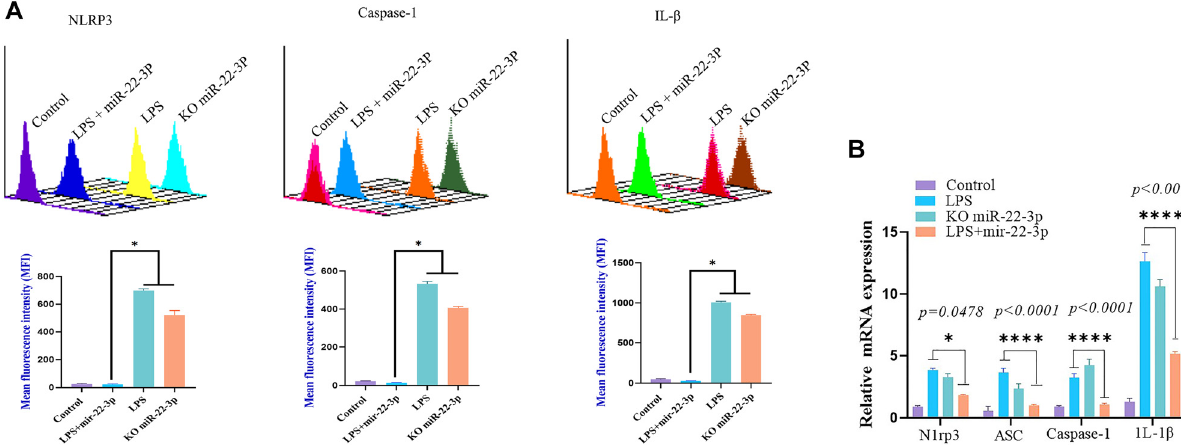
Figure 3: (A) The effect of up-regulation of miR-22-3p on the expression of NLRP3, IL-1 β or Caspase-1. Total RNAswere extracted from C28/I2 cells or tissue using TRIzol Reagent kit (Invitrogen ™ ) following the manufacture ’ s protocol. The total RNAs were subsequently subjected to cDNA synthesis by usingsuperscript II reverse transcriptase. RT-PCR was performed in the Materials and Methods section. (B) Inhibition of miR-22-3p enhanced the expression of NLRP3, IL-1 β and Caspase-1.